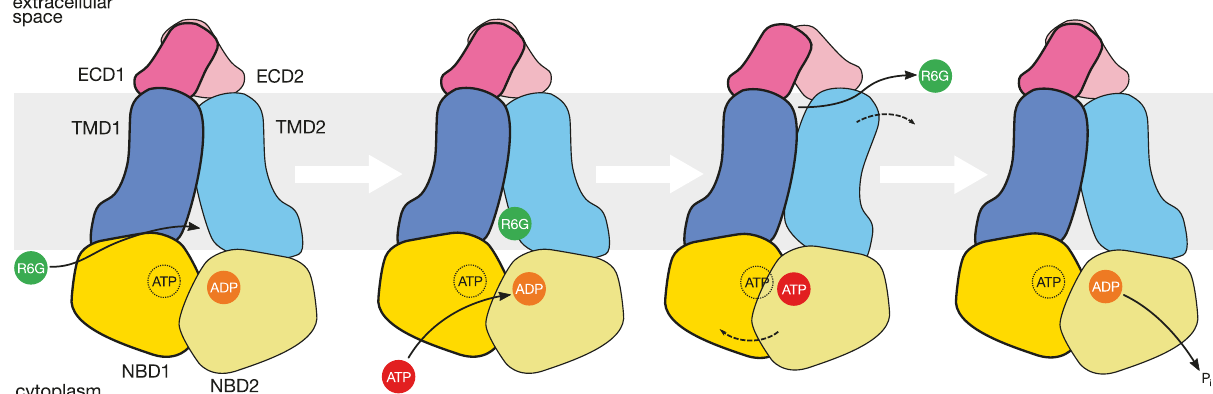
Fig. 7 Transport cycle of Pdr5. The substrate (in this case, rhodamine 6G) enters the cavity between the transmembrane domains from the cytoplasmic side when Pdr5 is in inward-facing conformation. ADP remaining in the catalytic site from the previous hydrolysis step is exchanged for ATP. ATP binding triggers a conformation change in Pdr5 from inward- to outward-facing, whereby the substrate is pushed through the substrate channel and released into the extracellular medium. Upon nucleotide hydrolysis, the transporter reverts to inward-facing conformation, ready to receive another molecule of substrate. In cellular conditions, an ATP molecule remains bound to the inactive site throughout the cycle. The asymmetric nature of nucleotide hydrolysis means that one half of Pdr5 makes a larger conformational move than the other. Abbreviations: ECD, extracellular domain; NBD, nucleotide-binding